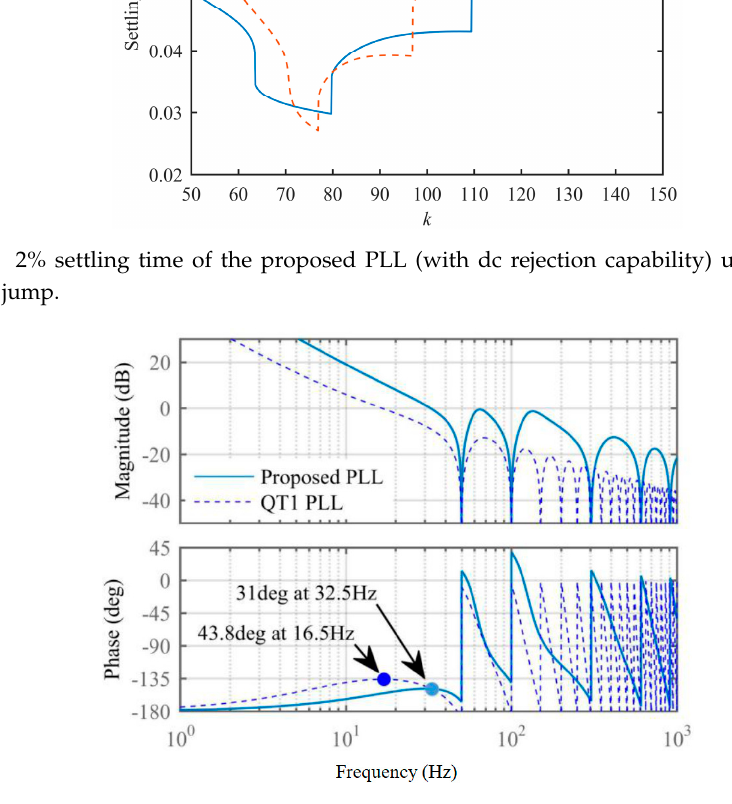
Figure 16. Open-loop bode plot of the proposed PLL and QT1-PLL (with dc rejection capability).